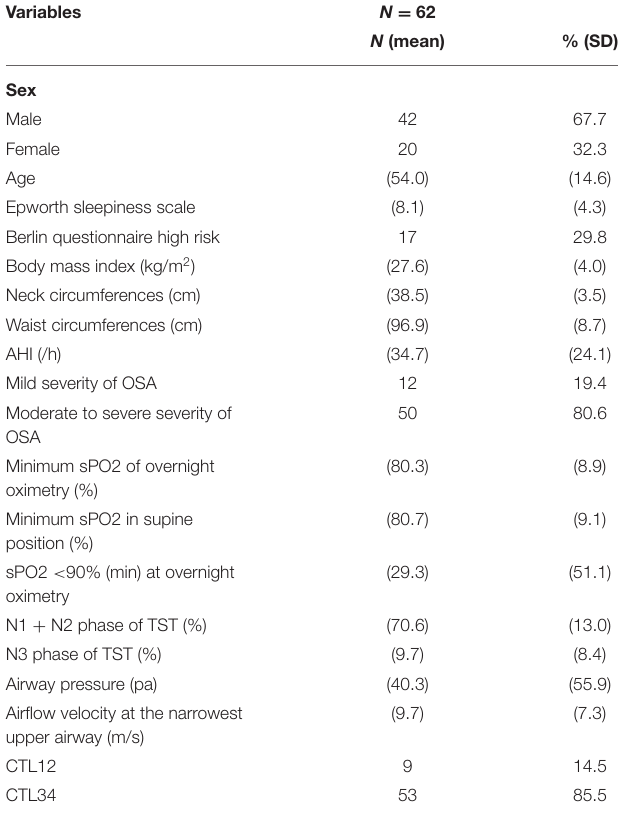
TABLE 1 | Demographic characteristics of study